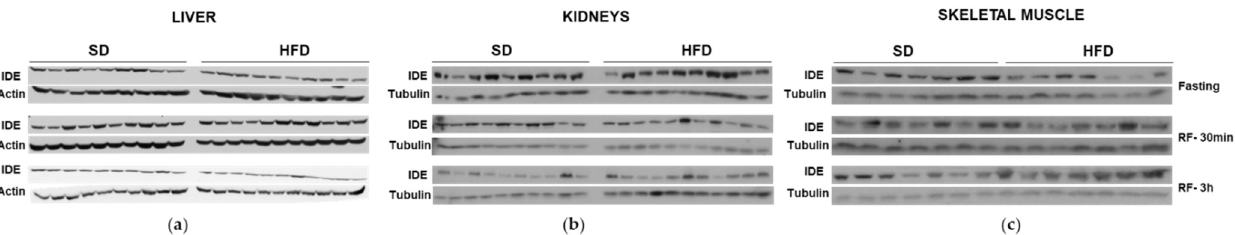
Figure A2. Effects of nutritional status on IDE protein levels. Mice were fed an SD or HFD for 8 weeks and IDE protein levels were analyzed under fasting and refeeding (30 min or 3 h) conditions. Full Western blot images for liver ( a ), kidneys ( b ), and skeletal muscle ( c ) are shown.